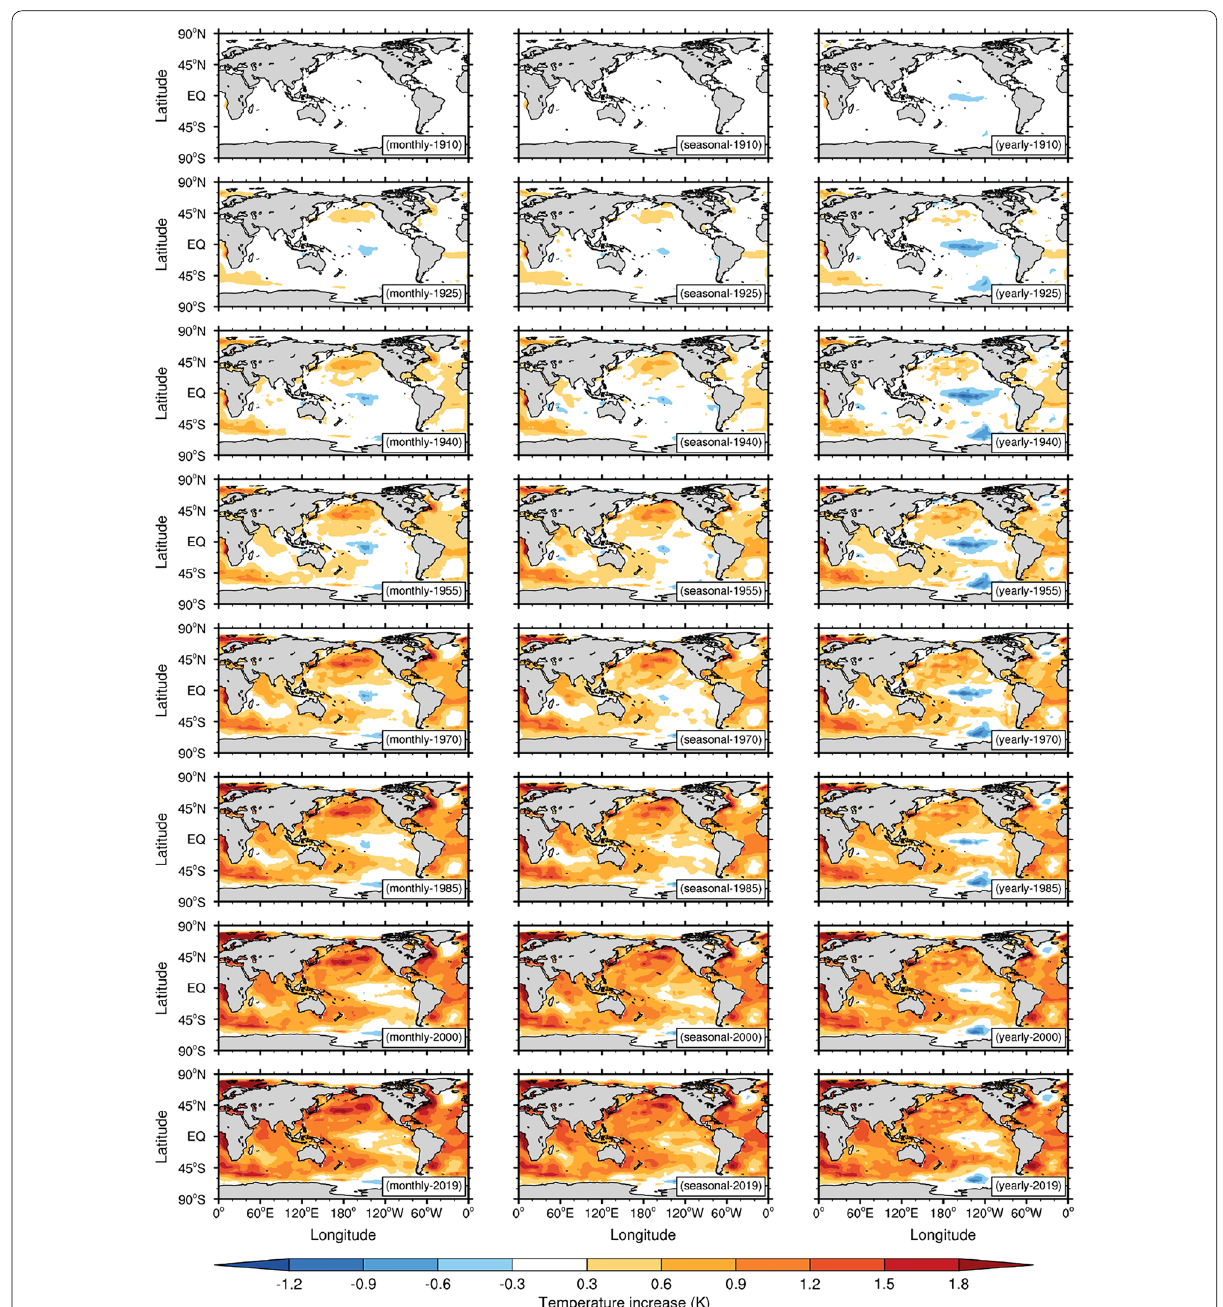
Fig. 1 Spatial evolution of the EEMD trend of global sea surface temperature tied to the sampling frequency. From top to bottom, the EEMD trend ended in 1910, 1925, 1940, 1955, 1970, 1985, 2000, and 2019, respectively. From left to right, EEMD trends are derived from monthly, seasonal, and annual data, respectively. Note that the color bar is the same as Xu et al. (2021) and